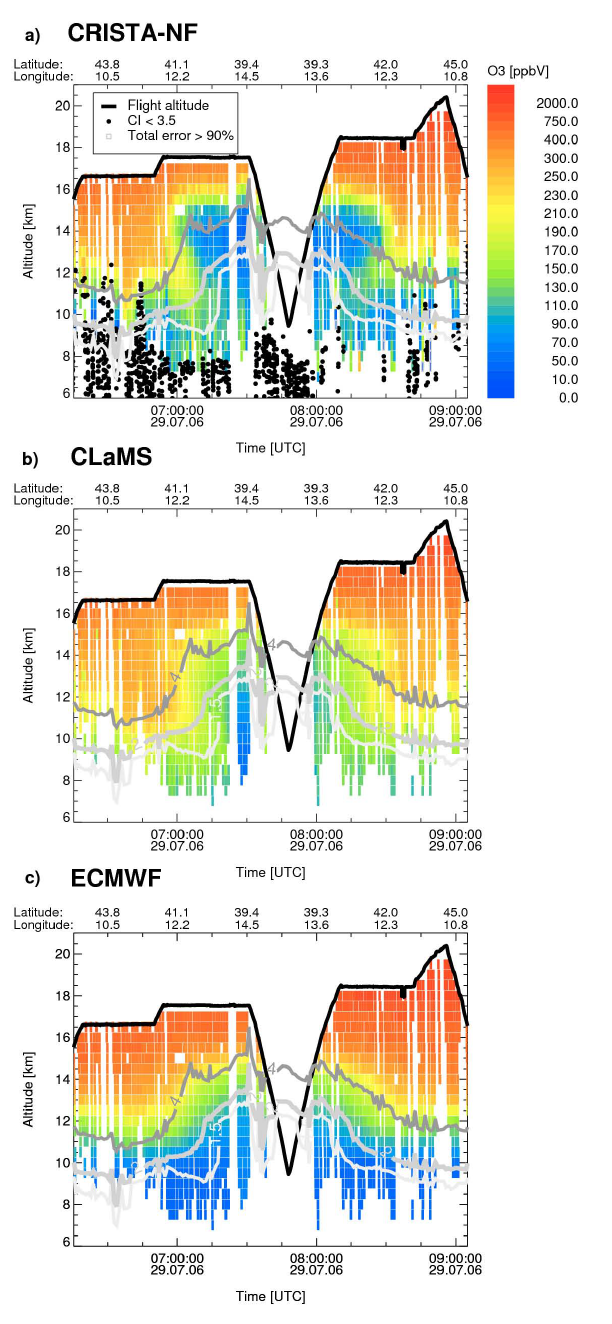
Fig. 4. O 3 from CRISTA-NF, CLaMS, and ECMWF analysis data. Colour scale shows the O 3 volume mixing ratio, grey lines show the ECMWF potential vorticity at 1.5, 2 and 4PVU, black line the flight track, black dots spectra with optical dense conditions, grey diamonds retrieval results with a total error larger than 90% (with CRISTA-NF O 3 ). Note nonlinear colour